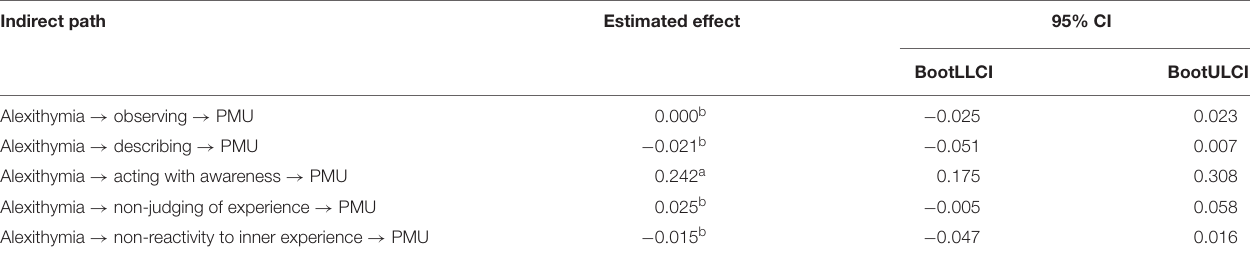
TABLE 3 | Bootstrapping indirect effect and 95% confidence interval (CI) for the mediation test. Indirect path